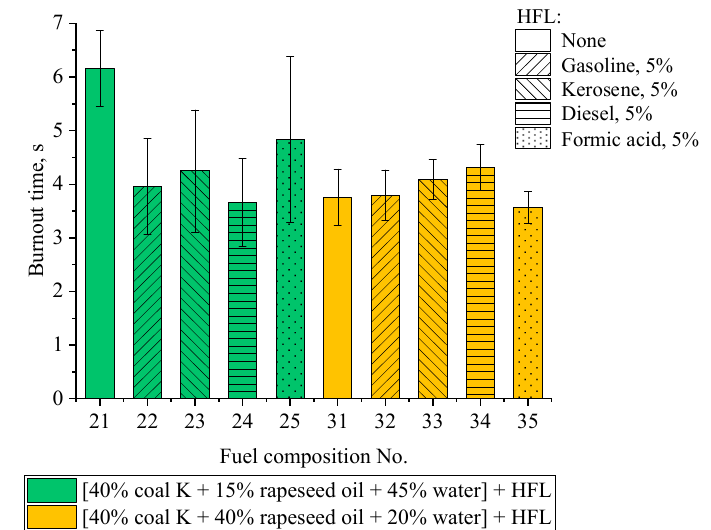
Figure 9. Burnout times of composite fuel droplets with different HFL additives.